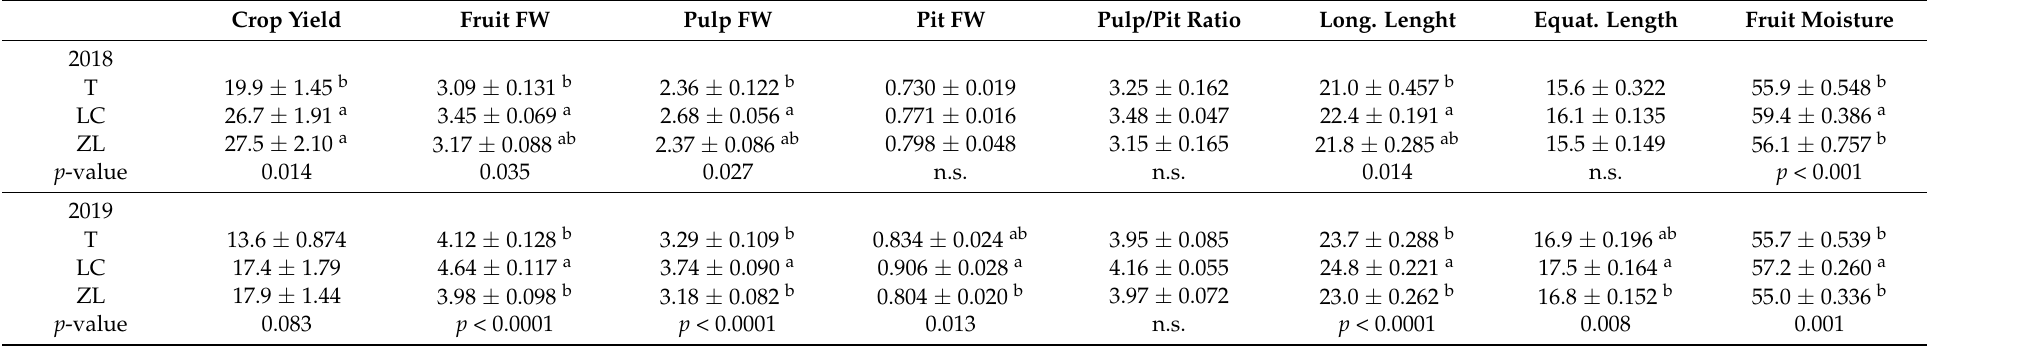
Table 1. Crop yield (kg fruit tree − 1 ) and fruit biometric parameters: fruit FW (g), pulp FW (g), pit FW (g), longitudinal length (mm), equatorial length (mm), fruit moisture (%) and pulp/pit ratio, as a function of soil treatment and harvest year. Crop Yield Fruit FW Pulp FW Pit FW Pulp/Pit Ratio Long. Lenght Equat. Length Fruit